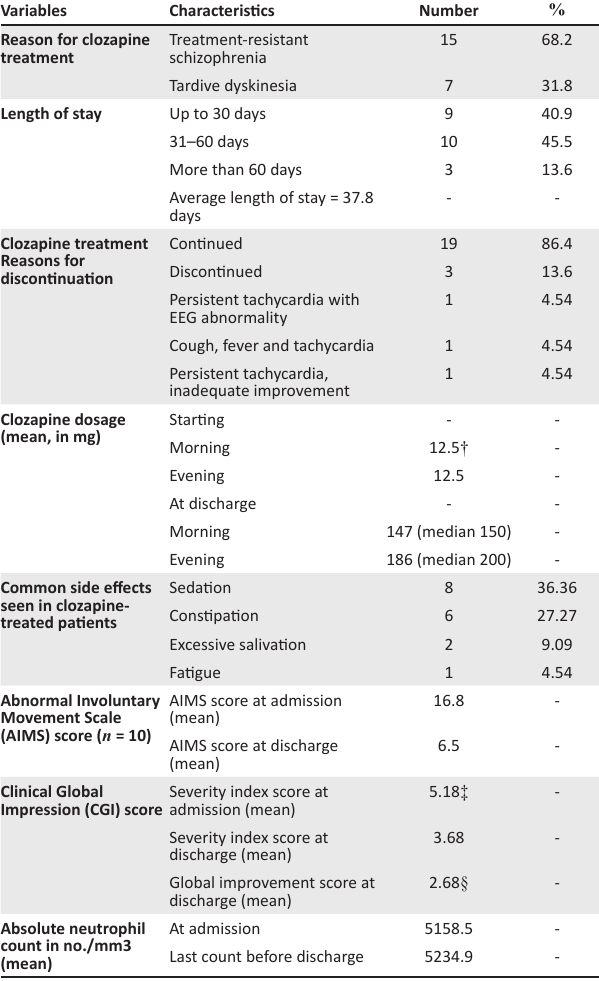
TABLE 1: Socio-demographic characteristics of patients treated with clozapine in Zewditu Memorial Hospital, Addis Ababa, Ethiopia, March 2019. Variables